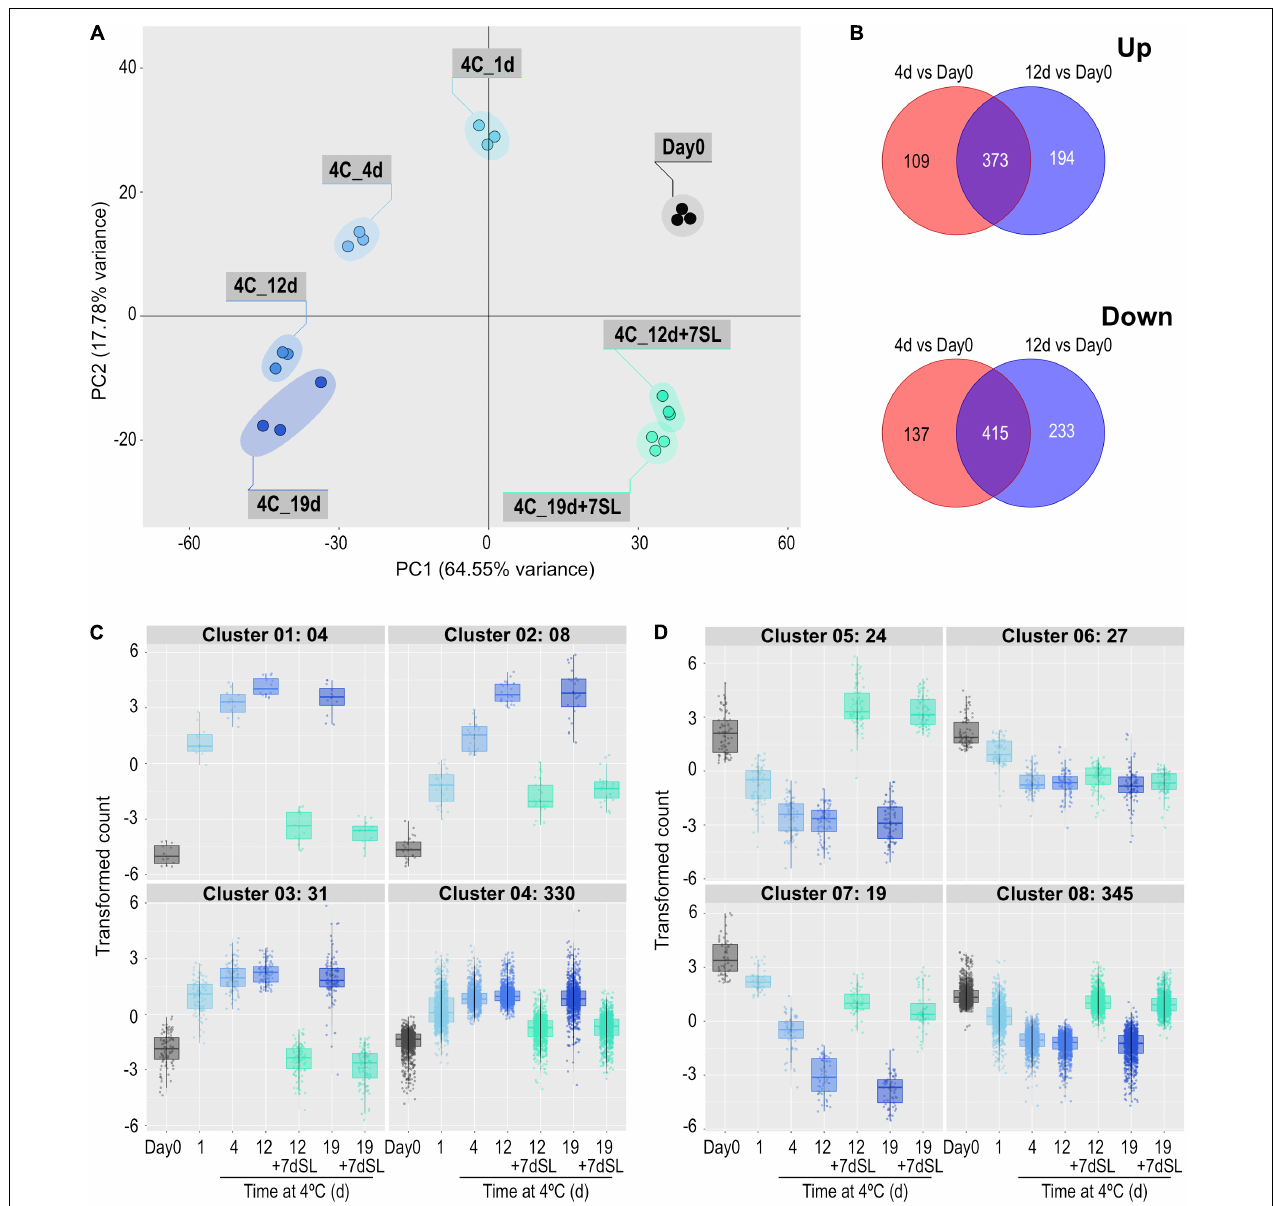
FIGURE 3 | Effect of storage at 4 ◦ C for various times on the ripe tomato fruit transcriptome. An additional 7-day period at a shelf-life (SL) temperature of 20 ◦ C was also included after 12 and 19 days. (A) Principal component analysis of transcriptome profiles based on the 50 most variable genes in each pairwise comparison (total of 617 most variable genes). (B) Venn diagrams showing numbers of genes differentially expressed at 4 and 12 days of exposure to 4 ◦ C, relative to Day 0. (C,D) Hierarchical cluster analysis of the gene sets that were up-regulated (373) and down-regulated (415) at both time points compared with Day 0. Expression patterns were clustered into four groups each for up-regulated (C) and down-regulated (D) genes. Genes were considered differentially expressed if they had a mean count in all compared samples of 200 or more, an adjusted P -value of 0.01 and > 3-fold increase or